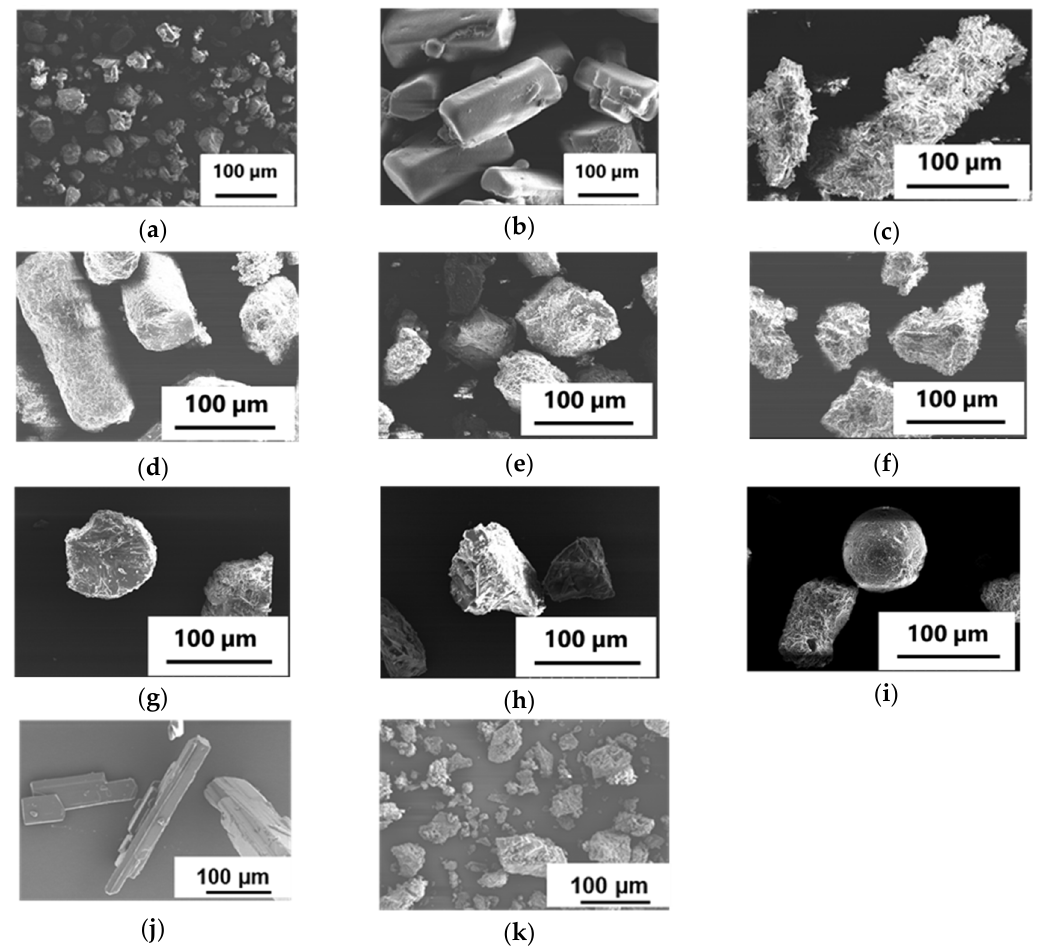
Figure 6. SEM images of CLZ-cocrystals prepared using the spray drying method. ( a ) CLZ, ( b ) 4HBA, ( c ) 2,4DHBA, ( d ) CLZ-4HBA SD80, ( e ) CLZ -4HBA SD100, ( f ) CLZ -4HBA SD120, ( g ) CLZ-2,4DHBA SD80, ( h ) CLZ-2,4DHBA SD100, ( i ) CLZ -2,4DHBA SD120, ( j ) 2,5DHBA, ( k ) CLZ -2,5DHBA